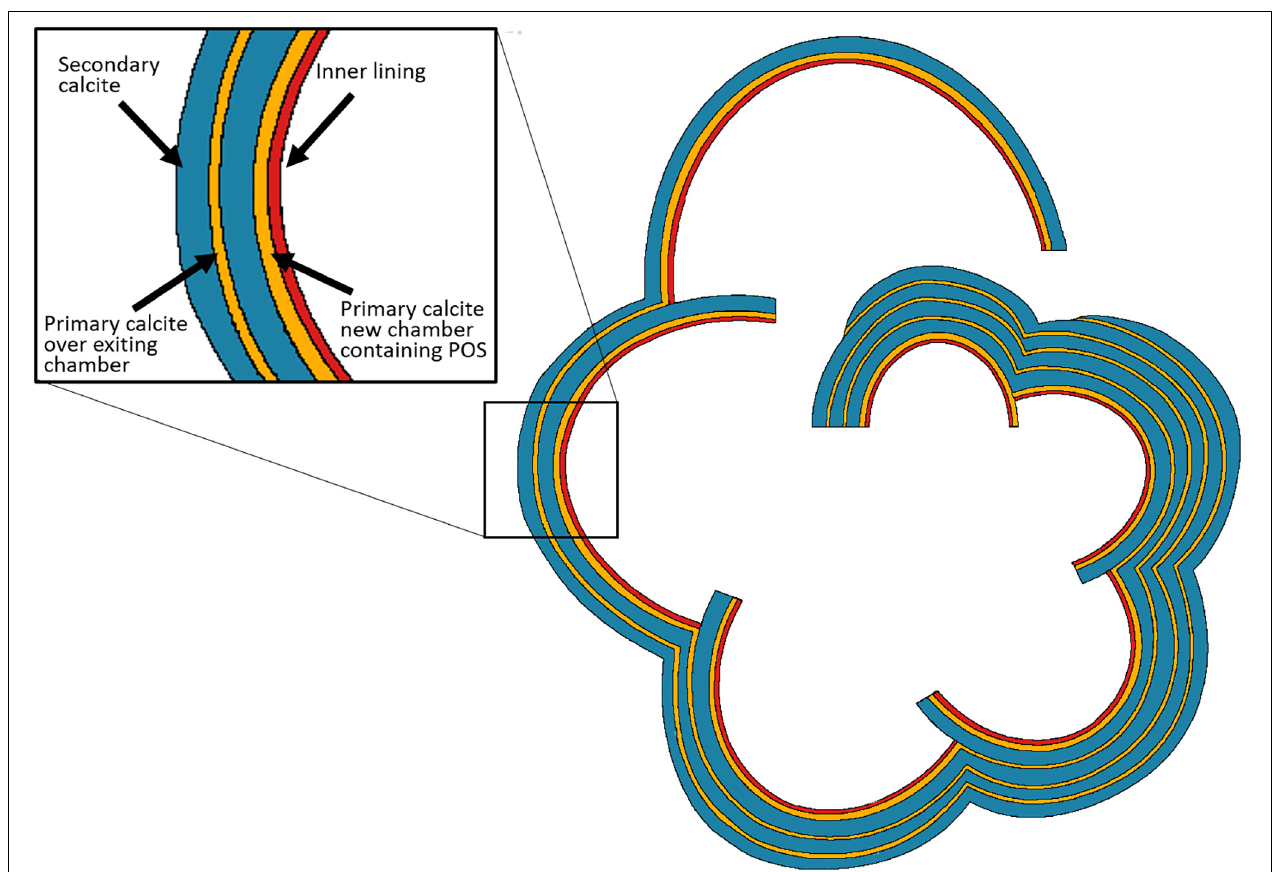
FIGURE 10 | Schematic drawing of a horizontal section showing the layering structure in laminated, perforate (calcitic radial) foraminiferal shell. These layers are represented also in the knob area of the two involute species of the genus Amphistegina in this study. Every new chamber contains thin layer of primary calcite (yellow) which precipitates over the primary organic sheet (POS) and is rich in Mg and other elements. The primary calcite is followed by a thick layer of secondary calcite (blue). The secondary calcite has much lower concentrations of Mg and other trace elements, which show radial crystal arrangement, described as “calcitic radial.” While the mechanism of formation of the primary calcite is not well known for this genus, the secondary calcite is precipitated from alkaline seawater vacuoles (Bentov et al., 2009). Each chamber contains another thin layer of calcite, the inner lining (red) which may also have laminations (Fehrenbacher et al., 2017). This scheme was originally suggested by Reiss, 1957, 1959 and here was modified from that of Erez